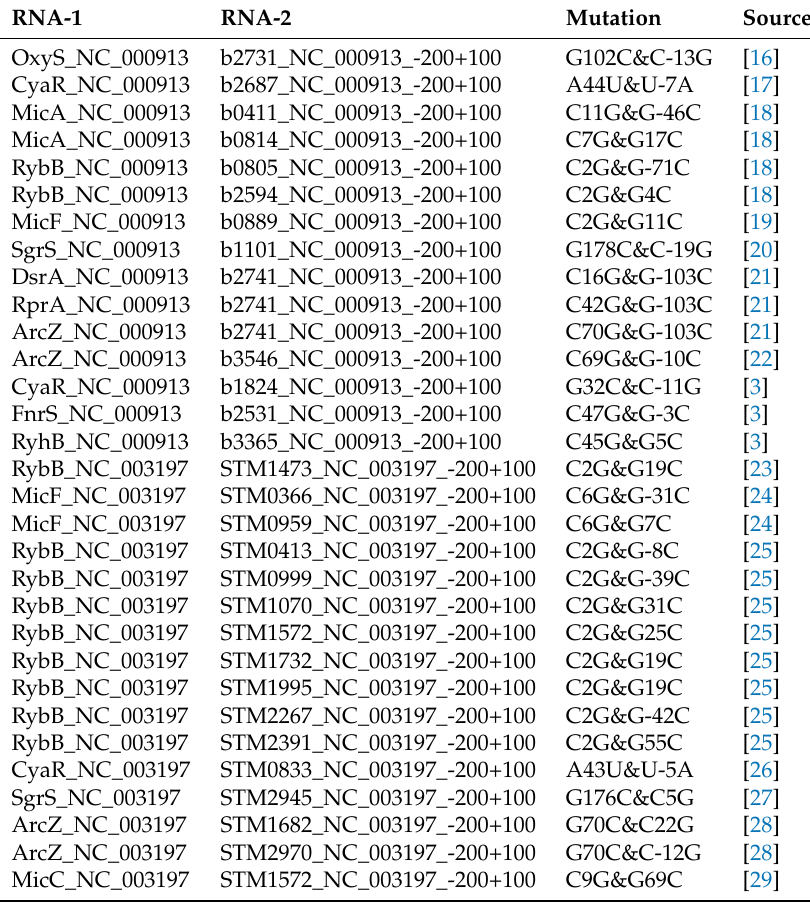
Table A1. Single-nucleotide CoMs from literature used for this study.